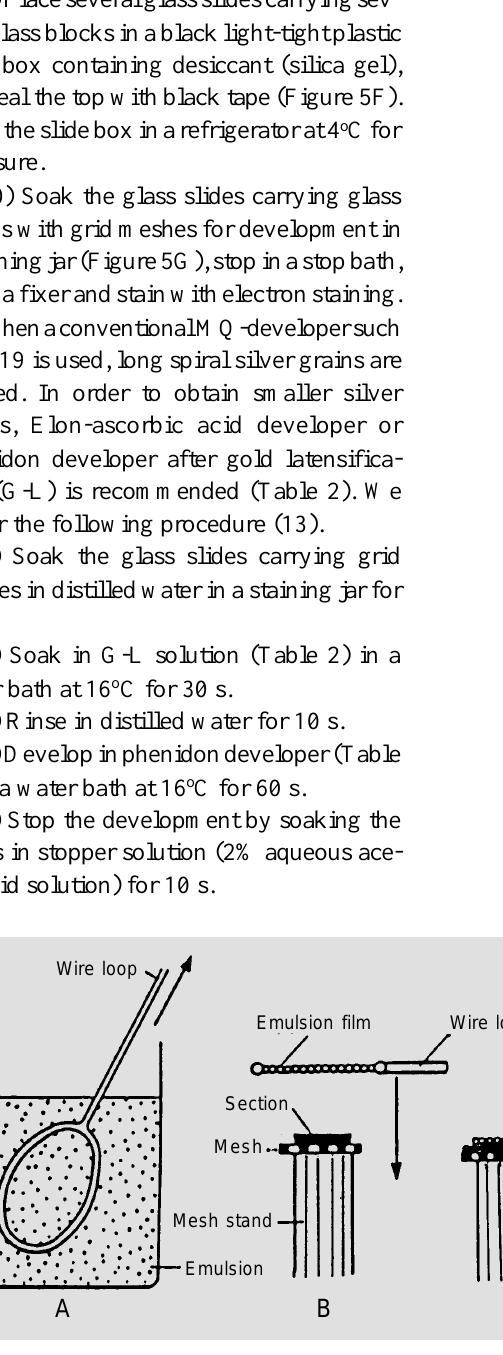
Figure 4 - Diagrams showing the procedures of the wire-loop method for EMRAG. A, A wire loop is dipped into melted and diluted emulsion and pulled up. B, A grid mesh carrying sections is placed on a mesh stand and sections are coated one by one with the emulsion film using a wire loop. C, The coated mesh is dried, exposed and